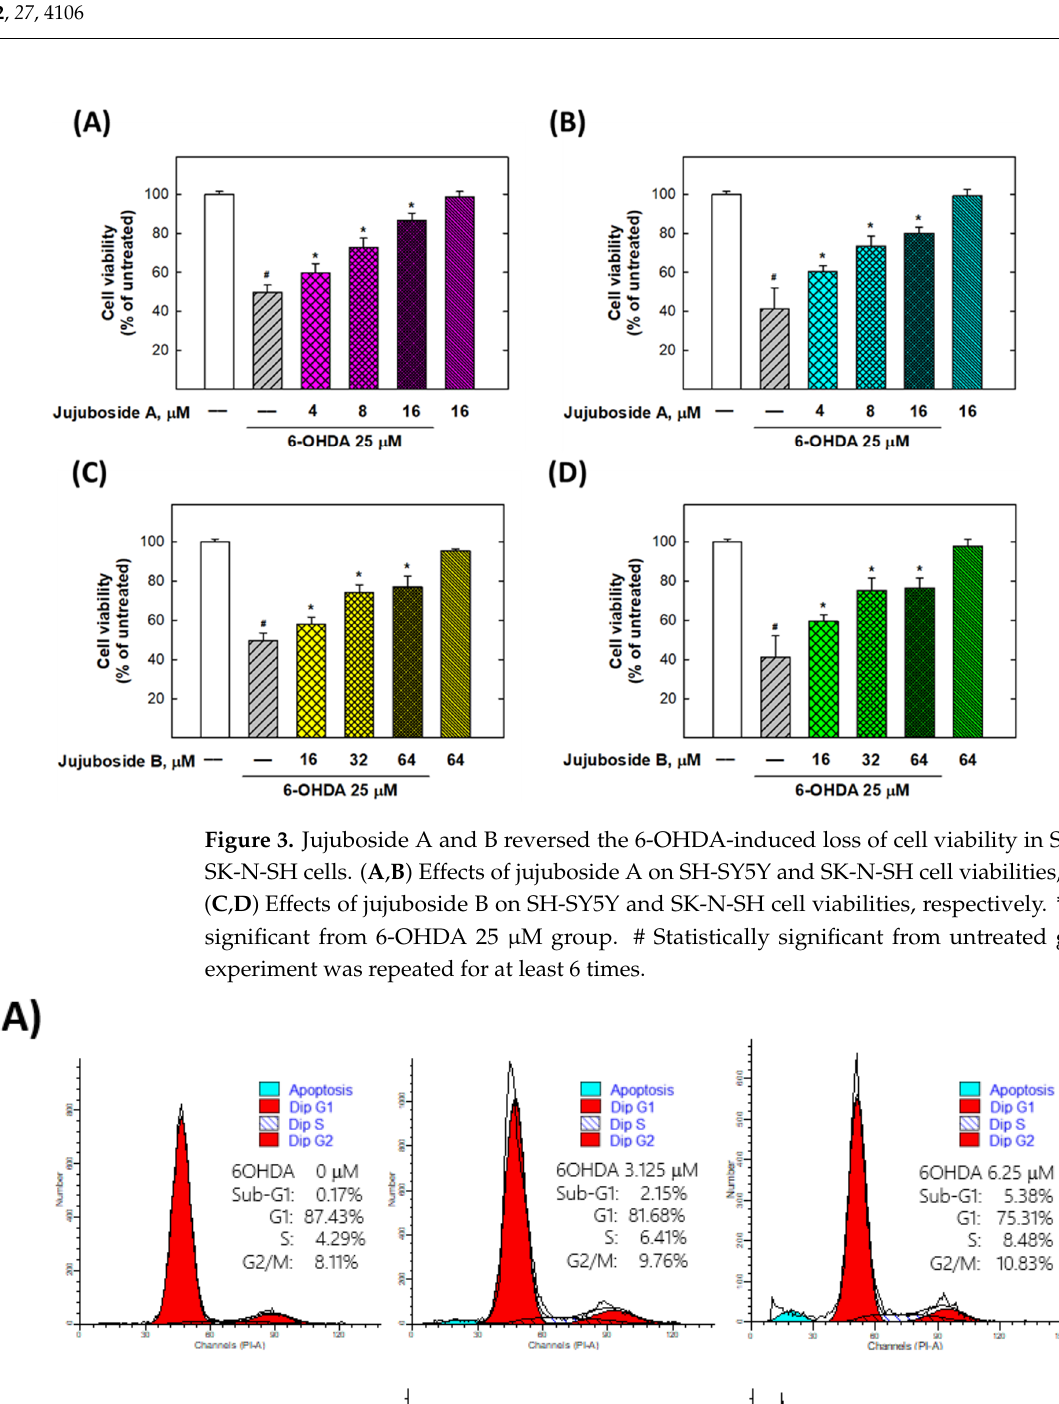
Figure 2. Suppressive effects of jujuboside A and B on cell viabilities in SH-SY5Y and SK-N-SH cells. ( A , B ) Suppressive effects of jujuboside A on SH-SY5Y and SK-N-SH cells, respectively. ( C , D ) Sup- pressive effects of jujuboside B on SH-SY5Y and SK-N-SH cells, respectively. * Statistically signifi- cant from untreated group. Each experiment was repeated for at least 6 times.